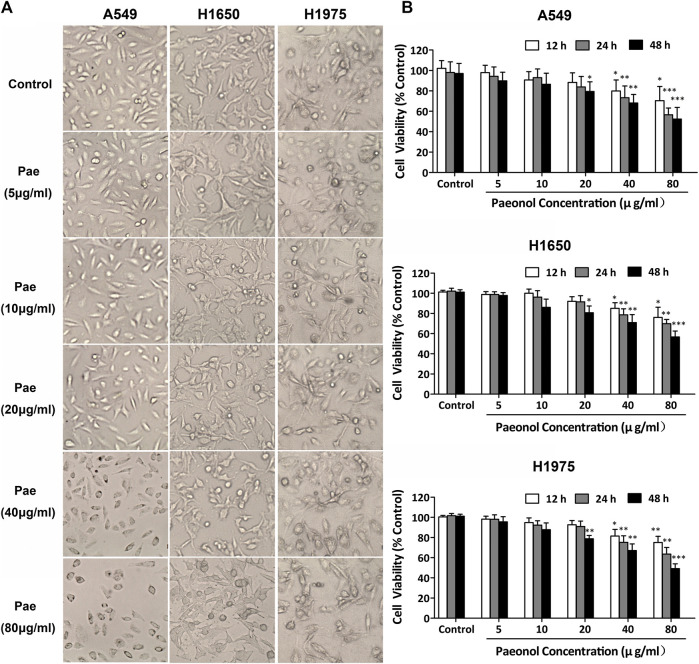
Paeonol inhibits proliferation in NSCLC cells. A549, H1650, and H1975 cells were treated with paeonol at indicated concentrations for 12, 24 or 48 h. (A) Representative morphological images of cells. Original magnification ×400. (B) MTS assays for evaluating cell proliferation, n = 3 (independent experiments). Signficance: *p < 0.05 vs. control, **p < 0.01 vs. control, ***p < 0.001 vs. control.